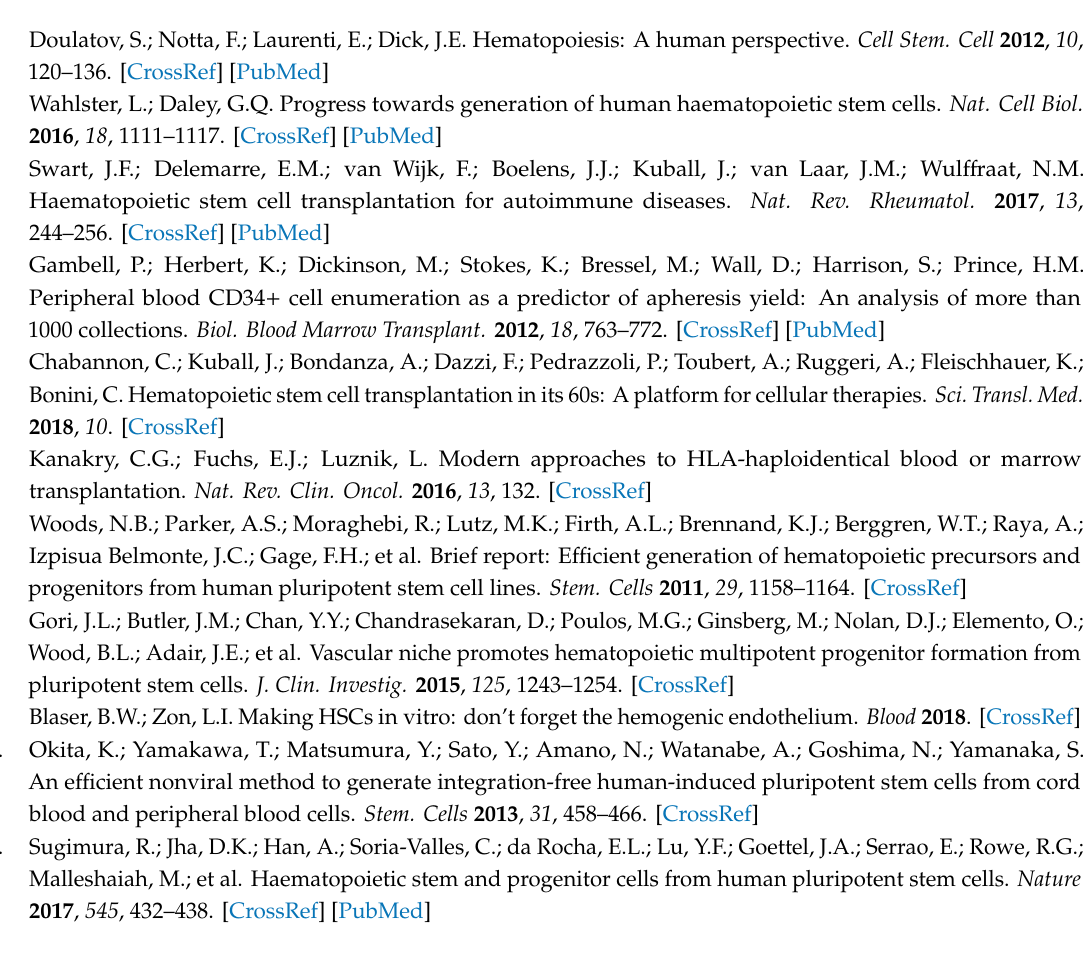
Figure S1: Scheme of the animal protocol for in vivo multiple di ff erentiation of miCD34 + HSC after transplantation into irradiated NSG